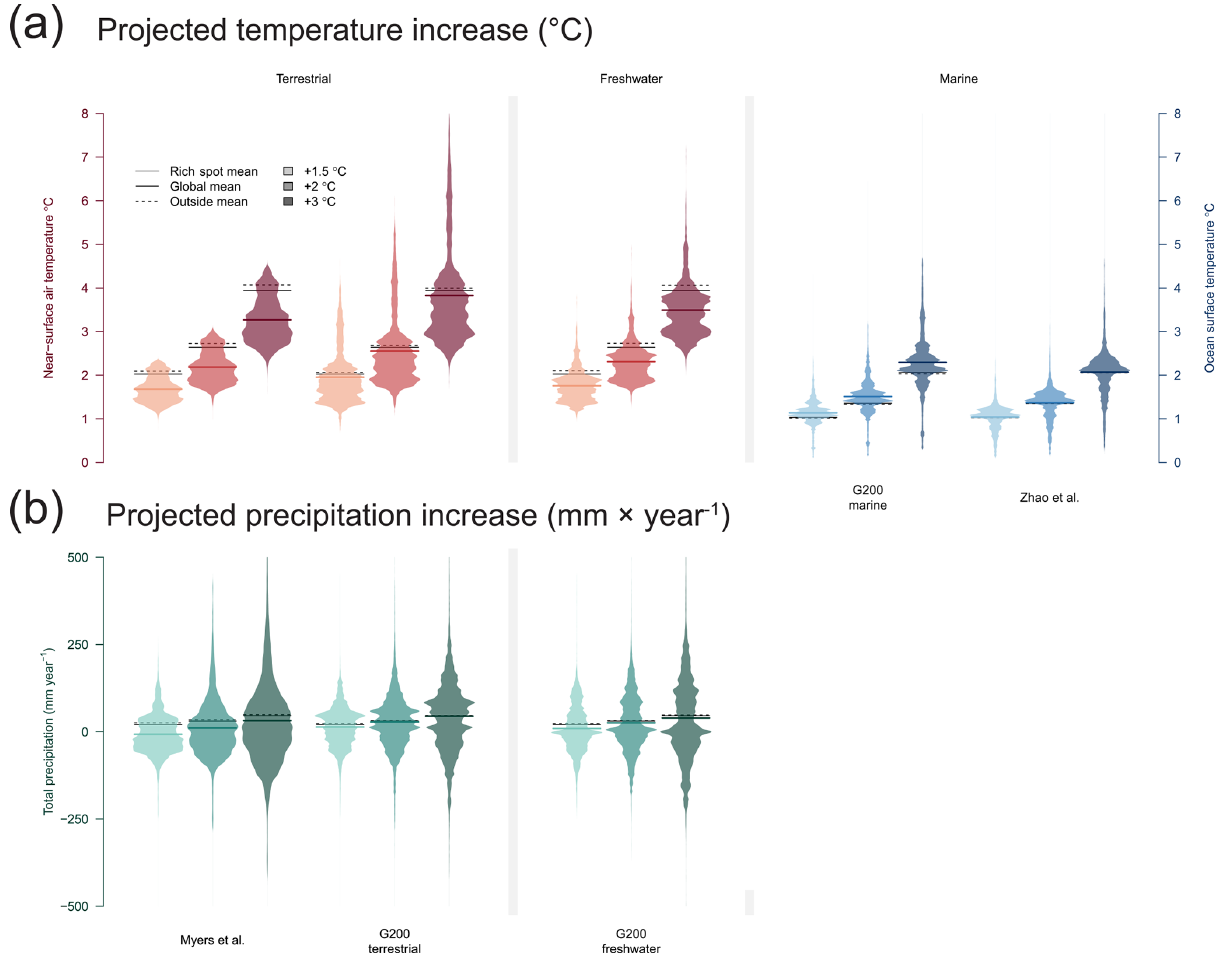
Figure 3. Future-projected temperature change and precipitation using the CMIP6-based scenarios at stages of + 1.5, + 2, and + 3 ◦ C global warming. Beanplots show the distribution of area (density of equal-area cells) in the rich spot scheme. Solid black lines indicate the land- or ocean-based global means, and dashed lines indicate the mean value outside and inside the rich